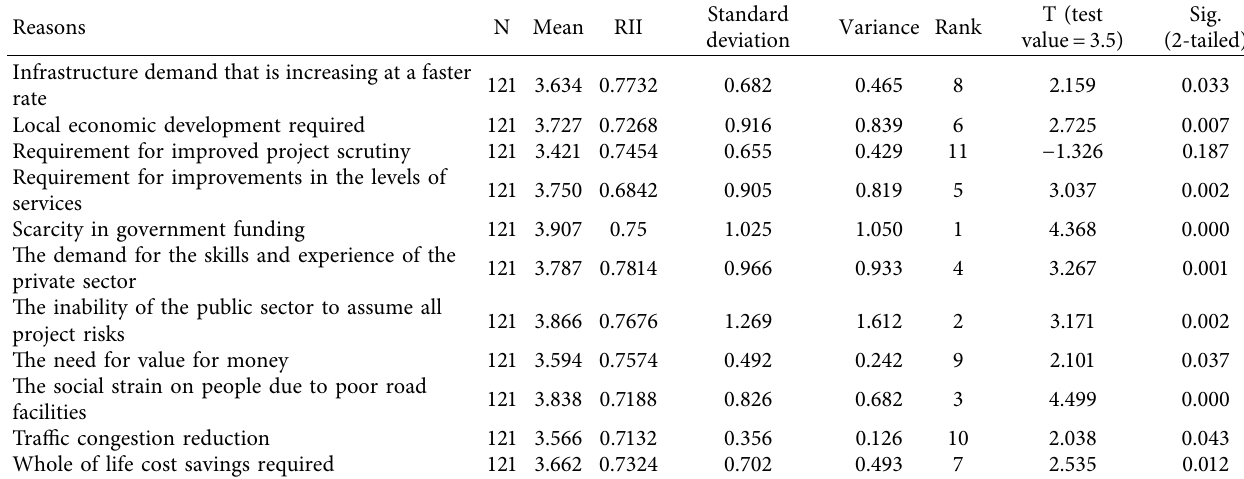
Table 4: Ranking of reasons for PPP implementation in the Ethiopian road